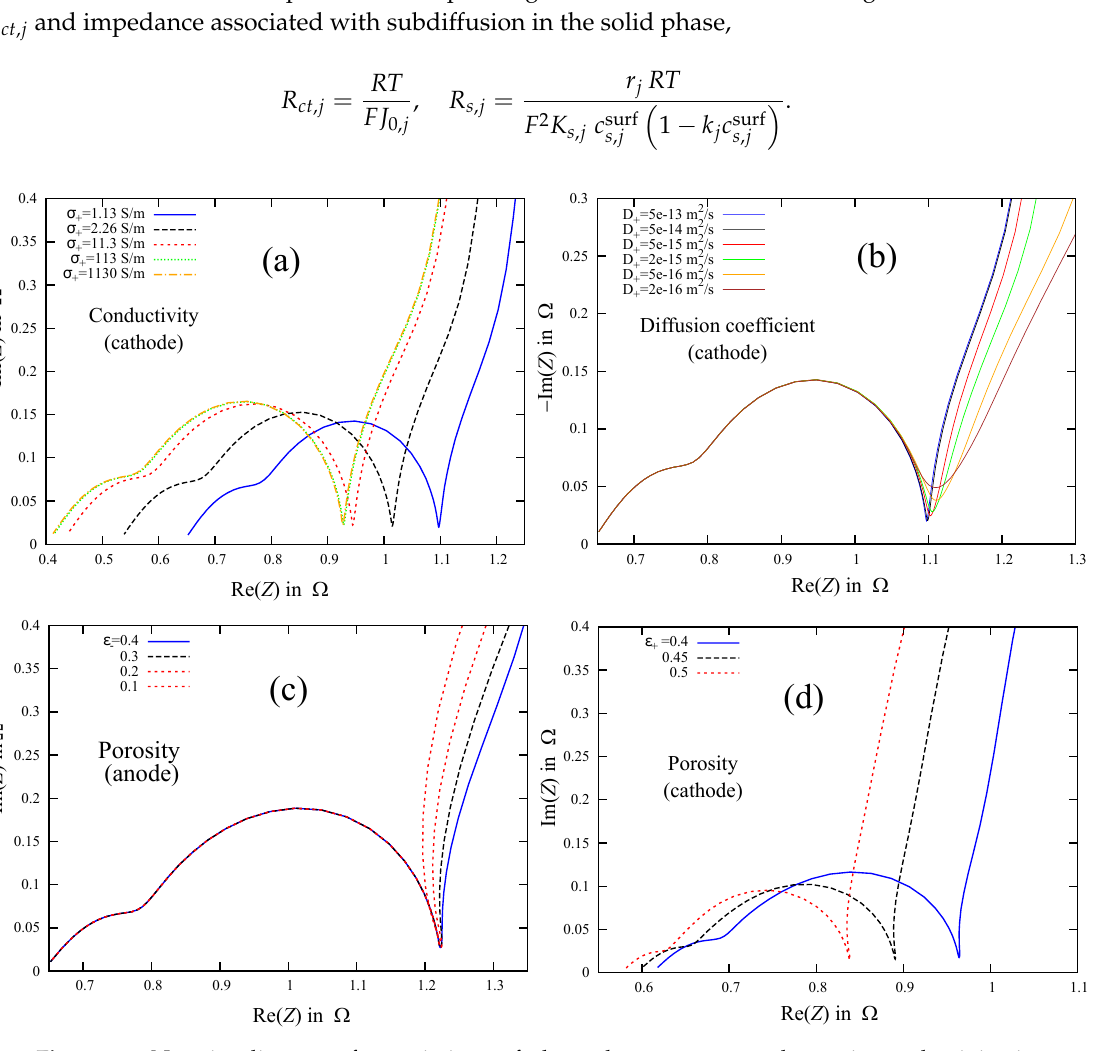
Figure 5. Nyquist diagrams for variations of electrode parameters: electronic conductivity in cathode ( a ), diffusion coefficient for ions in cathode particles ( b ), porosity of anode ( c ), and porosity of cathode ( d